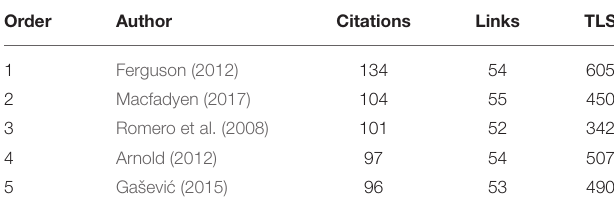
TABLE 6 | Top five most co-cited